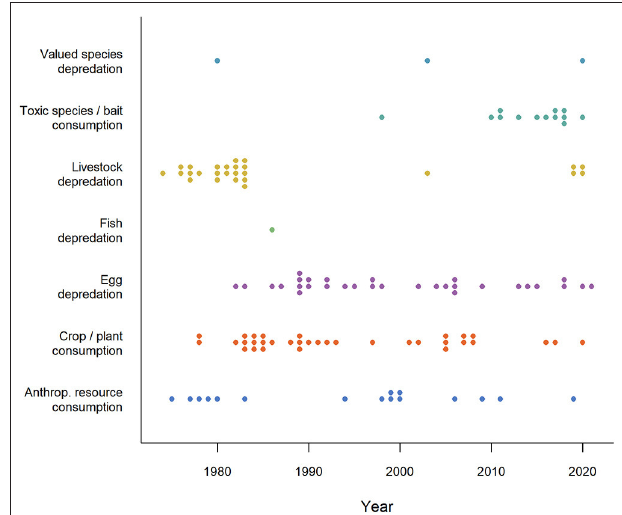
FIGURE 1 | Timeline of publications ( N = 124) investigating the application of conditioned taste aversion in seven human-wildlife contexts (1974-2021). The category “Valued species depredation” comprises depredation of species that do not fit in the other depredation categories (e.g., game, pets and protected species), “Anthropogenic resource consumption” comprises resources that do not fit the other HWC categories (e.g., beehives, landfills, food hand-outs). Numbers reported in this figure should be regarded as minimum estimates. Studies started in the 70’s primarily focusing on livestock depredation, human resource use (e.g., beehives) and crop consumption, continued with egg depredation in the 80’s and toxic species and bait consumption since the 90’s. Note that time lags for search engines may have caused some recent studies (2020-2021) to be omitted. Studies were retrieved via systematic search and ad hoc retrievals (see